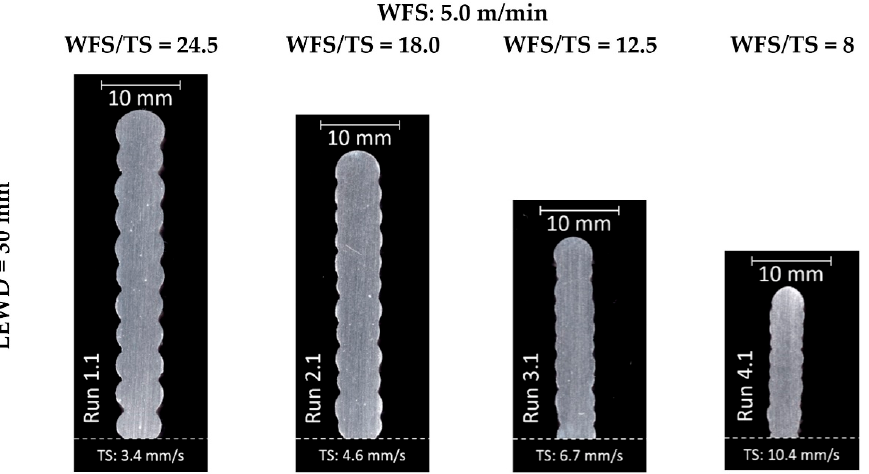
Figure 14. Typical cross-sections of the preforms deposited with the WFS at 5 m/min and LEWD at 30 mm.